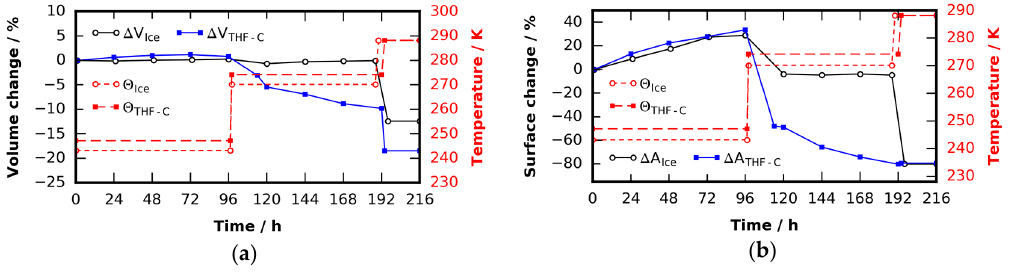
Figure 7. Structural analysis of the ice and THF clathrate decay study: ( a ) clathrate and ice volume changes as a function of time; and ( b ) clathrate and ice surface area changes as a function of time.